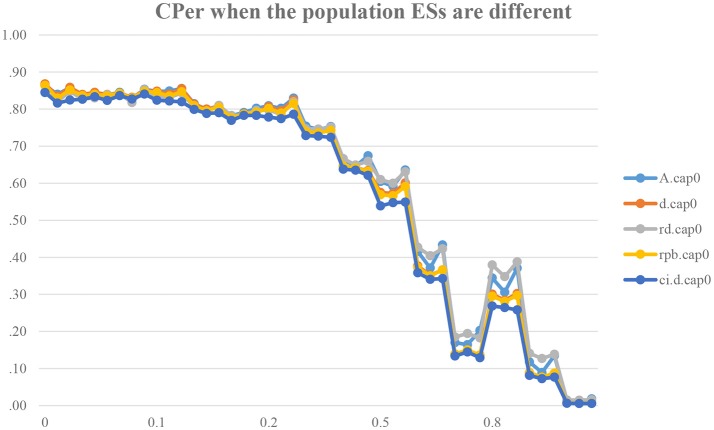
Capture Percentages across 45 conditions when the population true ESs are different. The y-axis shows the capture percentage. The x-axis shows the standardized mean difference of the original study, i.e., δo = (0,0.1, 0.2, 0.5, 0.8). A.cap0 is the CPer for A, d.cap0 is the CPer for Cohen's d, rd.cap0 is the CPer for robust d (dr), rpb.cap0 is the CPer for point-biserial correlation (rpb). The notation cap0 implies that the CPro should result in a null or unsuccessful (i.e., < 5%) capture procedure because the true effect sizes are different in the original and replicated studies. All these CPer methods are calculated based on the bootstrap CIs. The last term, ci.d.cap0, refers to the CPer based on the analytic CI surrounding Cohen's d.